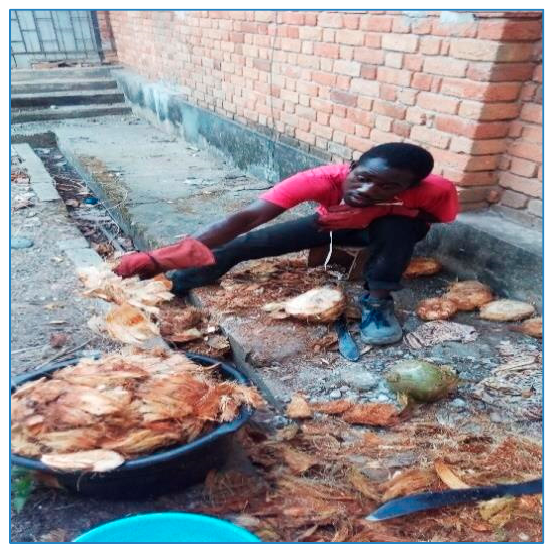
Figure 1. Picture showing the dehusking of fresh coconut fruit.